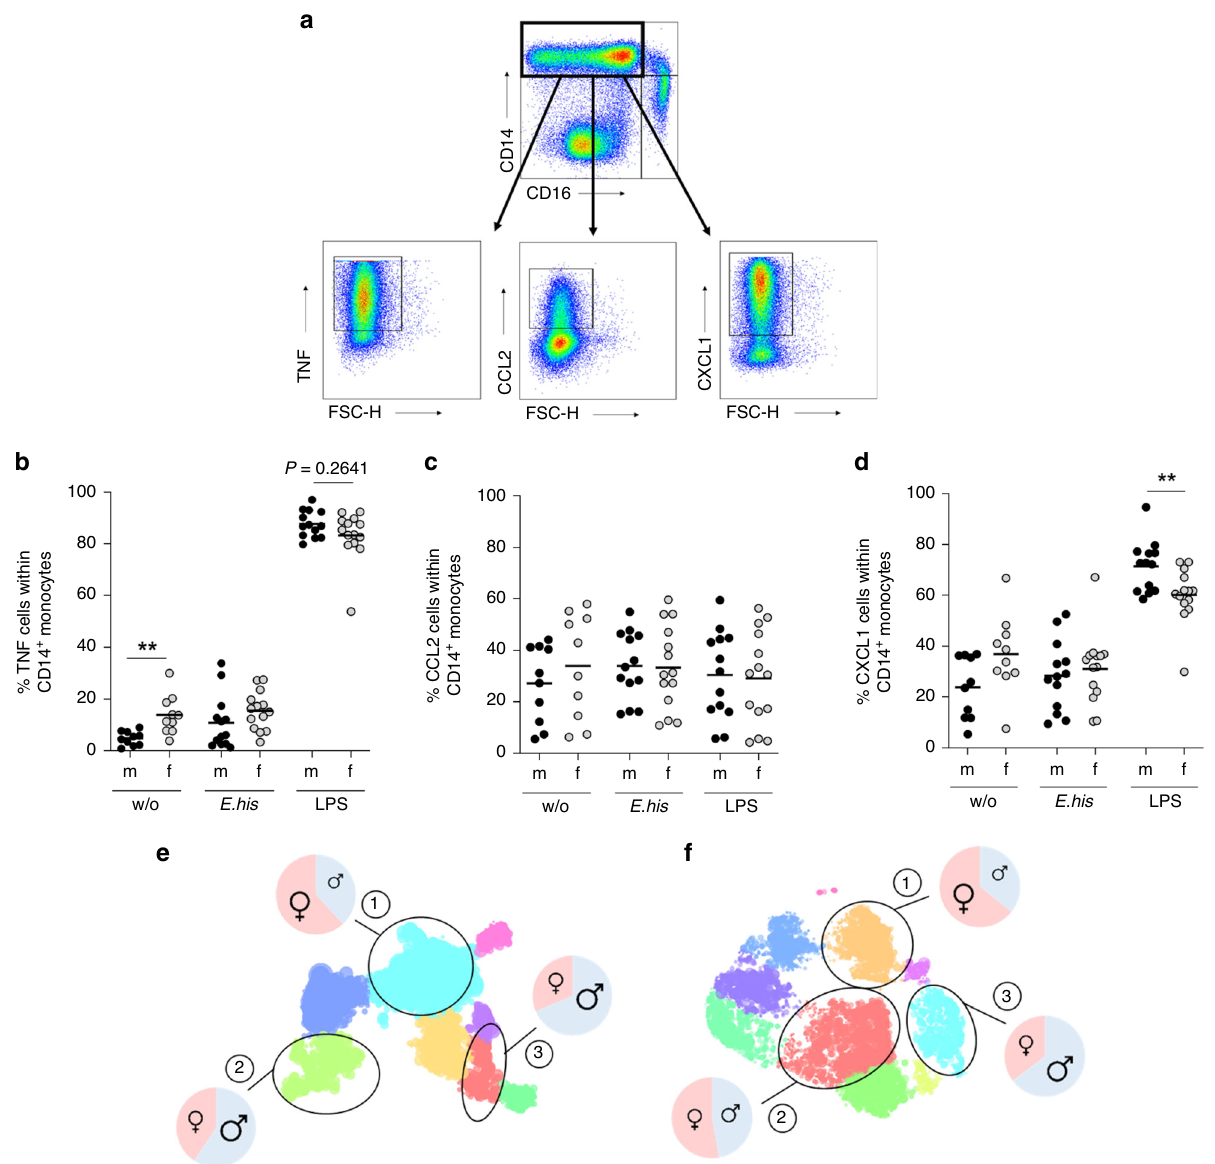
Fig. 4 TNF + , CXCL1 + , and CCL2 + classical monocytes are more abundant in men. a Gating strategy and representative dot plots showing cytokines produced by classical monocytes upon stimulation. PBMCs from men and women were stimulated for 6 h with E. histolytica lysate (0.1 mg/mL) or LPS (0.1 µ g/mL), and intracellular expression of b TNF, c CCL2, and d CXCL1 by classical monocytes was measured by fl ow cytometry and compared to unstimulated controls ( b n m/f w/o = 10/10; n m/f E. his = 13/14; n m/f LPS = 13/14; c n m/f w/o = 10/10; n m/f E. his = 13/14; and n m/f LPS = 13/14; d n m/f w/o = 10/10; n m/f E. his = 13/14; n m/f LPS = 13/14; pooled data from samples collected over a time frame of nine months; depicted are the means). Hierarchical